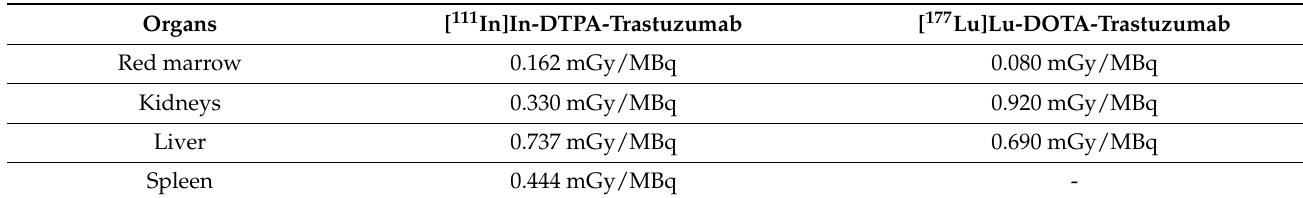
Table 2. Dosimetric data of [ 111 In]In-DTPA-trastuzumab and [ 177 Lu]Lu-DOTA-trastuzumab, obtained using the biodistribu- tion data ( n = 6).